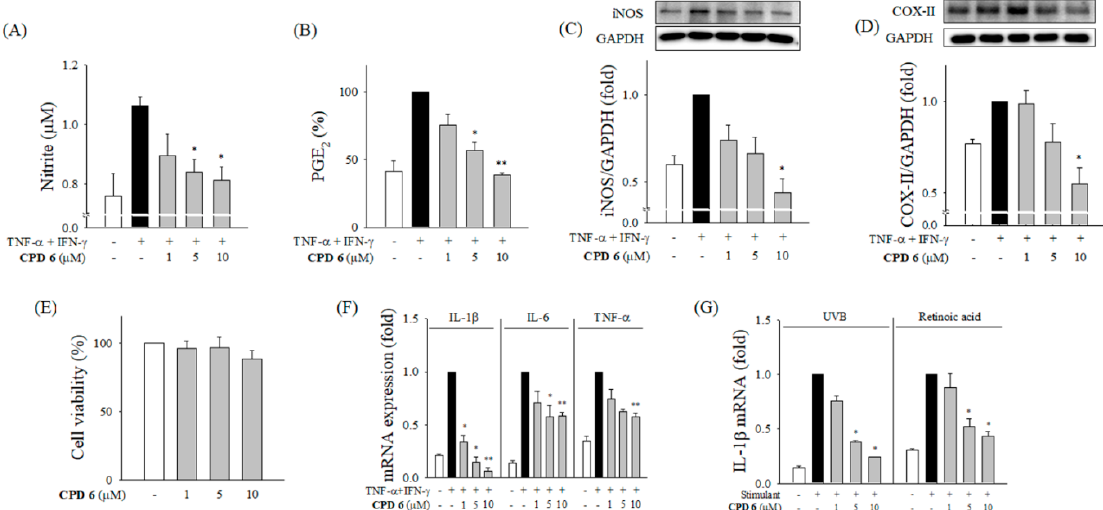
Figure 3. Attenuation of inflammatory signals in CPD 6 in keratinocytes challenged by TNF- α and IFN- γ , UV irradiation, or a chemical irritant. ( A and B ) Effect of CPD 6 on the release of NO ( A ) and PGE 2 ( B ) was measured after 24 h challenge of TNF- α +IFN- γ combination (10 ng/mL each) in human keratinocytes, HaCaT cells. The released amount of NO or PGE 2 was determined by Griess reaction or ELISA, respectively. ( C and D ) The protein levels of iNOS ( C ) or COX-II ( D ) were measured in HaCaT cells activated by TNF- α /IFN- γ . ( E ) Effects of CPD 6 on the cell viability of HaCaT cells were examined by MTT assay. ( F ) The levels of mRNA for IL-1 β , IL-6, and TNF- α were measured in human keratinocytes stimulated by TNF- α /IFN- γ using quantitative real time PCR. ( G ) The mRNA levels of IL-1 β in keratinocytes were examined at 6 h after UVB irradiation (25 mJ/cm 2 ) or exposure to retinoic acid (50 μ M). ( G ) Data are expressed as mean ± SEM, * p < 0.05, ** p < 0.01 vs. TNF- α /IFN- γ or UVB or retinoic acid-treated group. N = 3.